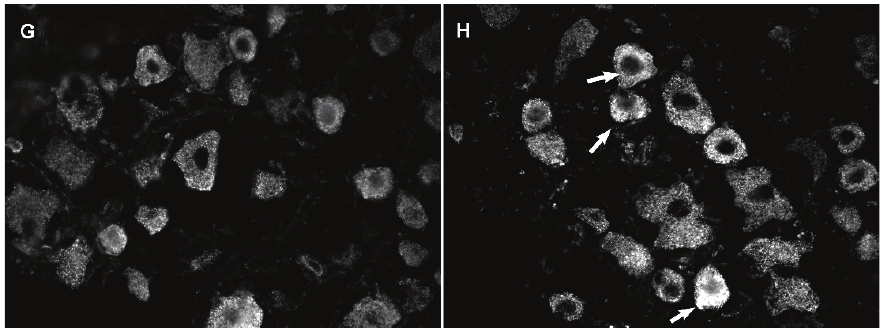
Figure 2. Representative images of glutaminase (GLS) immunoreactivity (ir) in lumbar 4 (L4) dorsal root ganglion (DRG) neurons ipsilateral to the PBS and CFA injected hind paws after one ( A , B ); two ( C , D ); four ( E , F ); and eight ( G , H ) days of AIA. Left column images are from PBS injected rats. Right column images are from CFA injected rats. All sizes of DRG neurons have GLS-ir. ( F ) After four days of hind paw inflammation, GLS-ir increased (arrows) in many DRG neurons, regardless of neuronal size, ipsilateral to CFA injection compared to PBS injected controls. ( H ) GLS-ir was still elevated in some small neurons (arrows) after eight days of inflammation compared to controls.